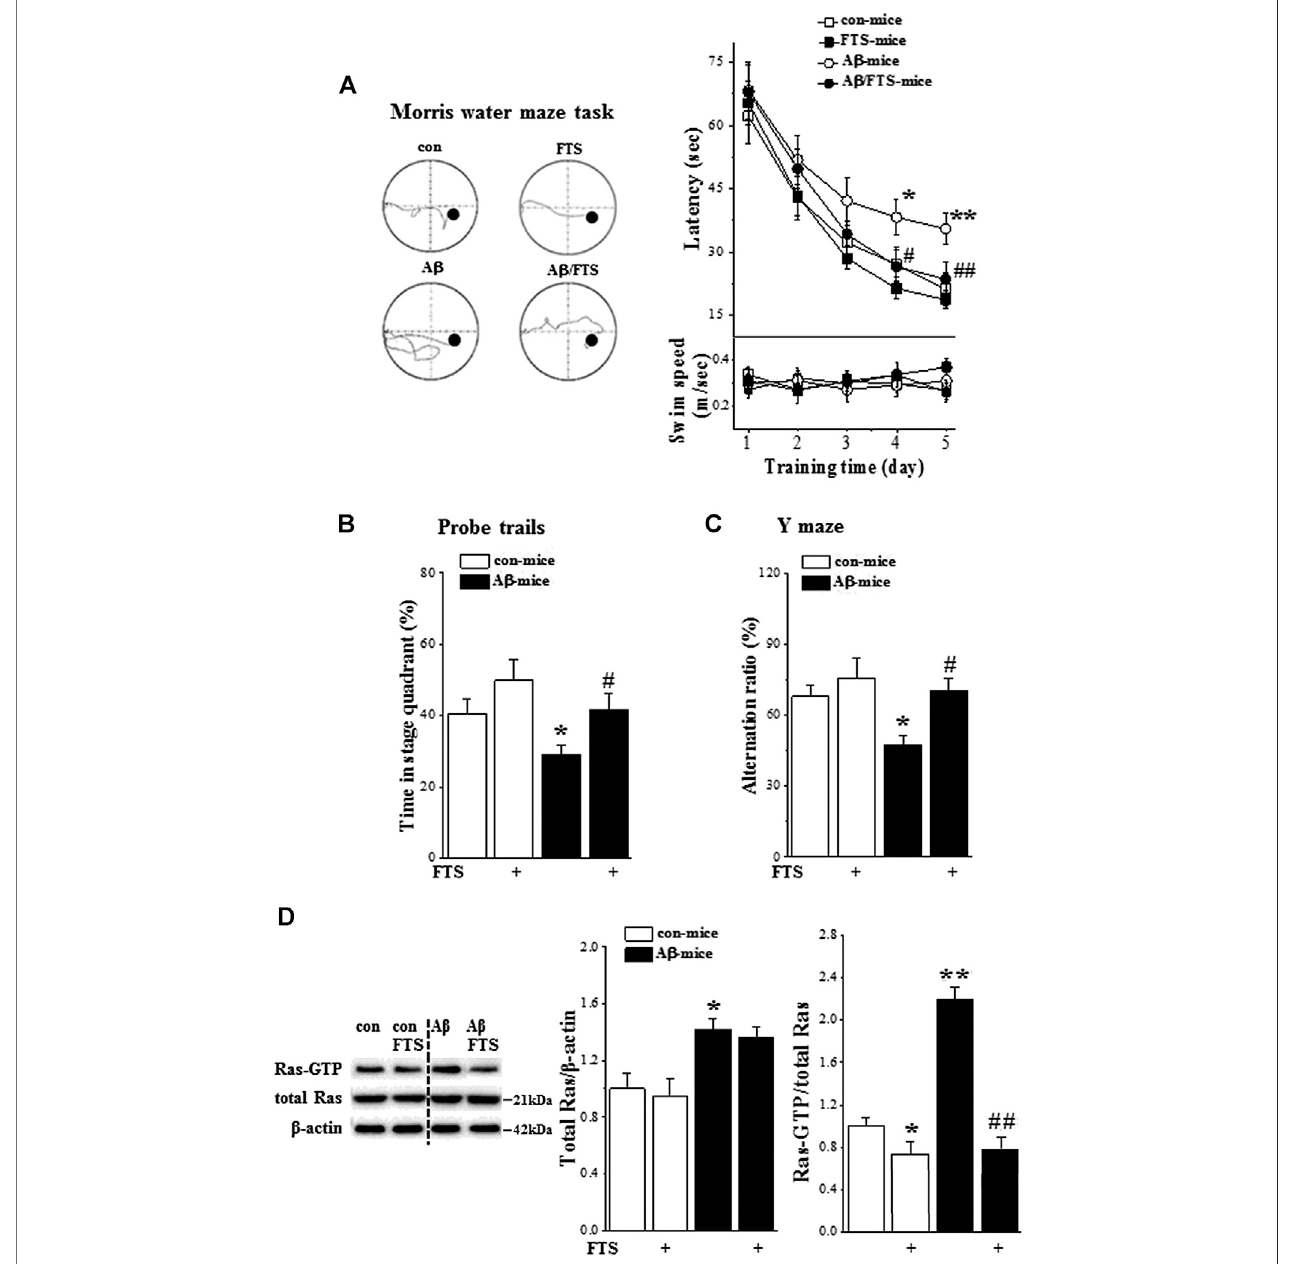
FIGURE2| A β 1-42 impairsspatialcognition via Rashyperactivation. (A) Eachpoint(upperpanel)indicatesgroupmeanlatency(sec)toreachthehidden-platformin control mice (con-mice), A β 1-42 -mice (A β -mice), FTS-treated control mice (FTS-mice) and FTS-treated A β 1-42 -mice (A β /FTS-mice). Each point (bottom panel) indicates mean swim speed (m/sec). Left panels show representative swimming tracks of mice searching for the underwater platform at day 5 after training. * p < 0.05 and ** p < 0.01 vs. control mice; # p < 0.05 and ## p < 0.01 vs. A β 1-42 -mice (repeated-measures ANOVA, n (cid:1) 8 per group). (B) Bars present the percentage of time spent in target quadrant of probe trails. * p < 0.05 vs. control mice; # p < 0.05 vs. A β 1-42 -mice (two-way ANOVA, n (cid:1) 8 per group). (C) Bar graph indicates group mean of alternation rate (%) in Y-maze task. * p < 0.05 vs. control mice; # p < 0.05 vs. A β 1-42 -mice (two-way ANOVA, n (cid:1) 8 per group). (D) Effects of A β 1-42 on expression and activation of hippocampal Ras. Bar graphs represent the levels of total Ras protein and Ras-GTP in mice. The mean value per experimental group was normalized by control mice. * p < 0.05 and ** p < 0.01 vs. control mice; ## p < 0.01 vs. A β 1-42 -mice (two-way ANOVA, n (cid:1) 6 per group).